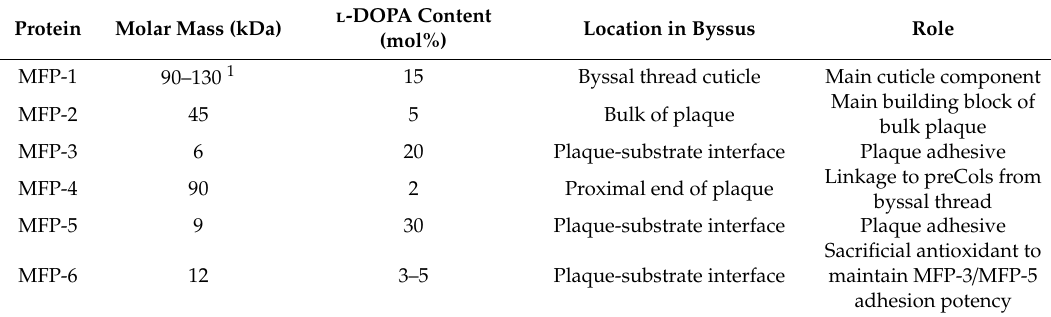
Table 1. Main characteristics of mussel foot proteins (MFPs) in mytilids [19,20,39,43]. Protein Molar Mass (kDa) Location in